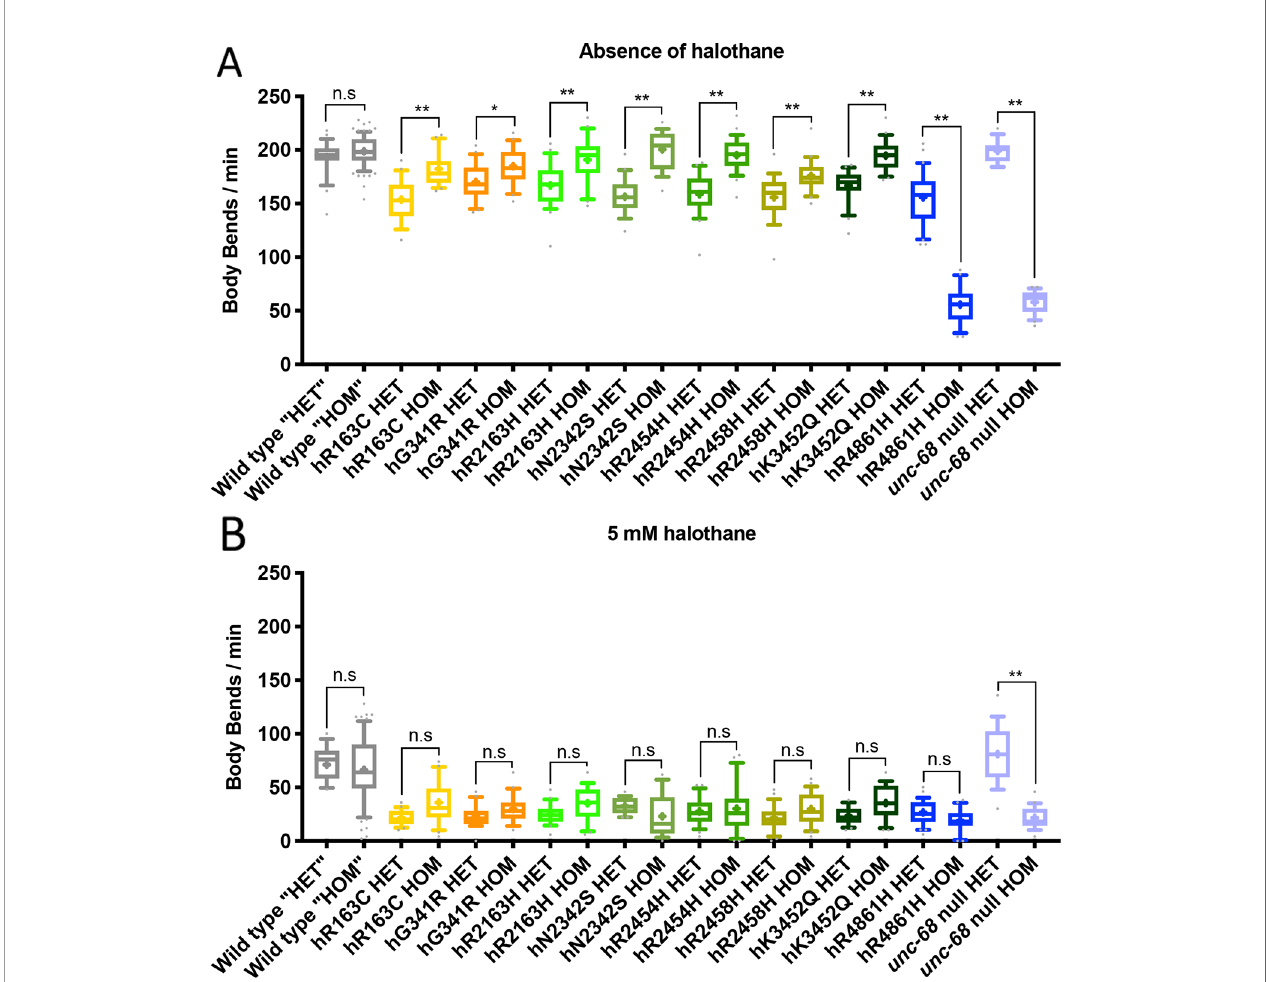
FIGURE 6 | Locomotion effects in heterozygous ryanodine receptor (RyR) variant individuals. Thrashing rate in S medium, in body bends per minute, for 25 individuals, in the absence of (A) and presence of (B) 5 mM halothane. Those expressing RyR variants are identi fi ed by the human variant they correspond to, and were either heterozygous (HET), with the modi fi ed unc-68 over a wild type unc-68 introduced by mating, or homozygous (HOM) for the modi fi ed unc-68 . Corresponding N2 wild type and unc-68(e540 ) null mutant individuals were generated and assayed in the same way, in parallel, for direct comparison, although the wild type “ heterozygotes ” ( “ HET ” ) and “ homozygotes ” ( “ HOM ” ) are fully wild type for unc-68 . Boxes indicate the median and interquartile range, with whiskers to the 10 – 90 percentile, outliers as dots, and + to indicate the mean. Signi fi cance is between heterozygotes and homozygotes. * P < 0.05, ** P < 0.005, n.s, not signi fi cant (one-way ANOVA, with Sidak ’ s multiple comparison